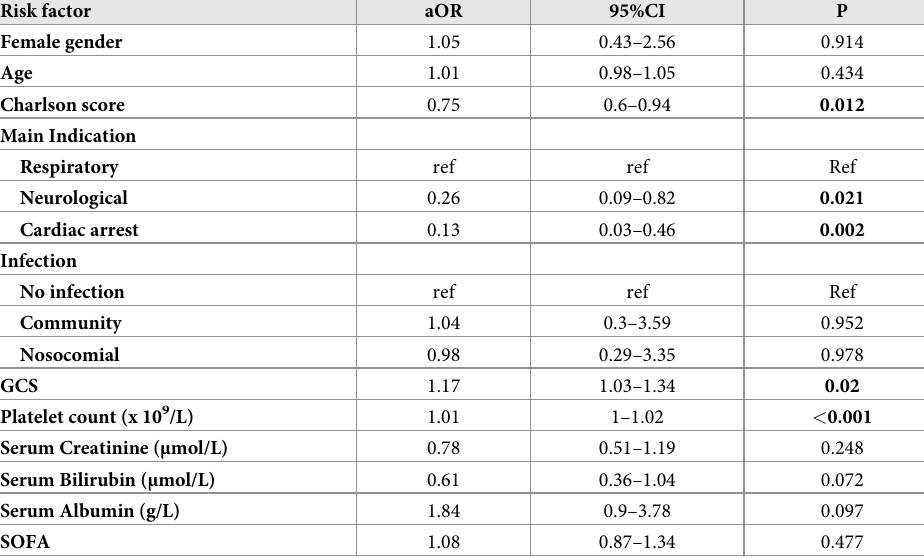
Table 4. Multivariate binary logistic regression analysis for the prediction of ICU